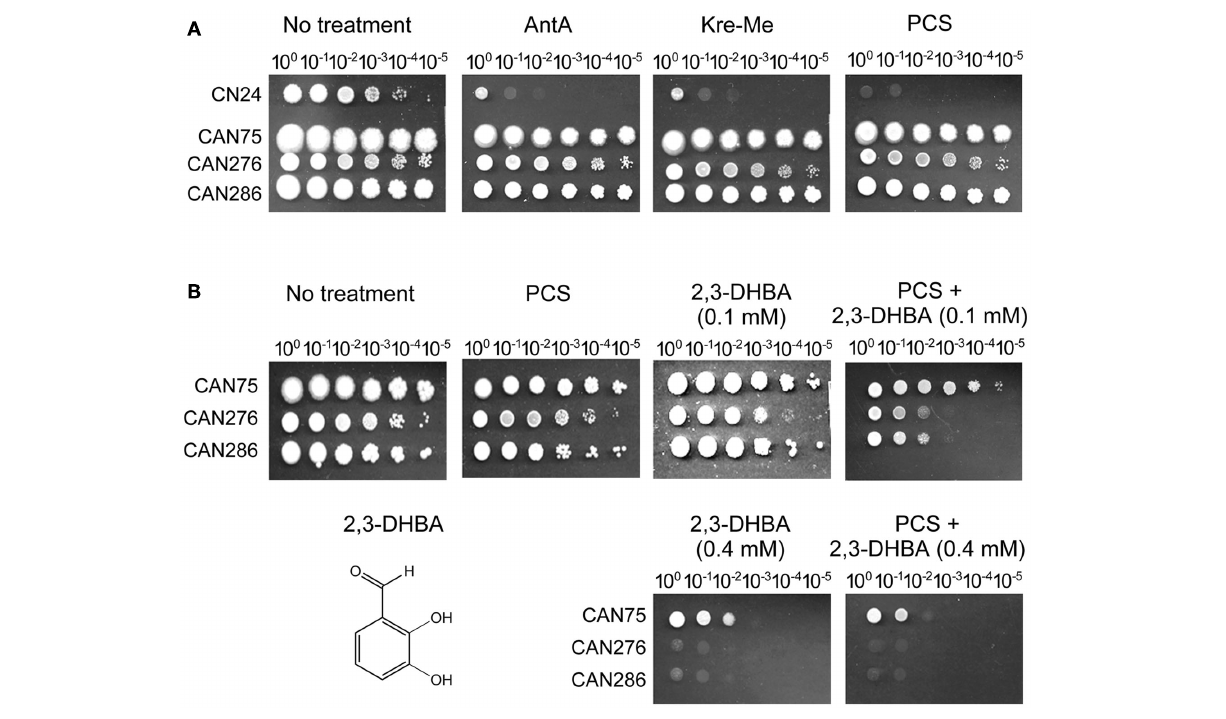
CAN276, C. krusei CAN75, C. tropicalis CAN286). (B) Co-application of 2,3-DHBA (0.1mM) and PCS (100 μ gmL − 1 ) enhanced the inhibition of the growth of C. albicans CAN276 and C. tropicalis CAN286, while similar type of growth inhibition of C. krusei CAN75 could be achieved by increasing the concentration of 2,3-DHBA up to